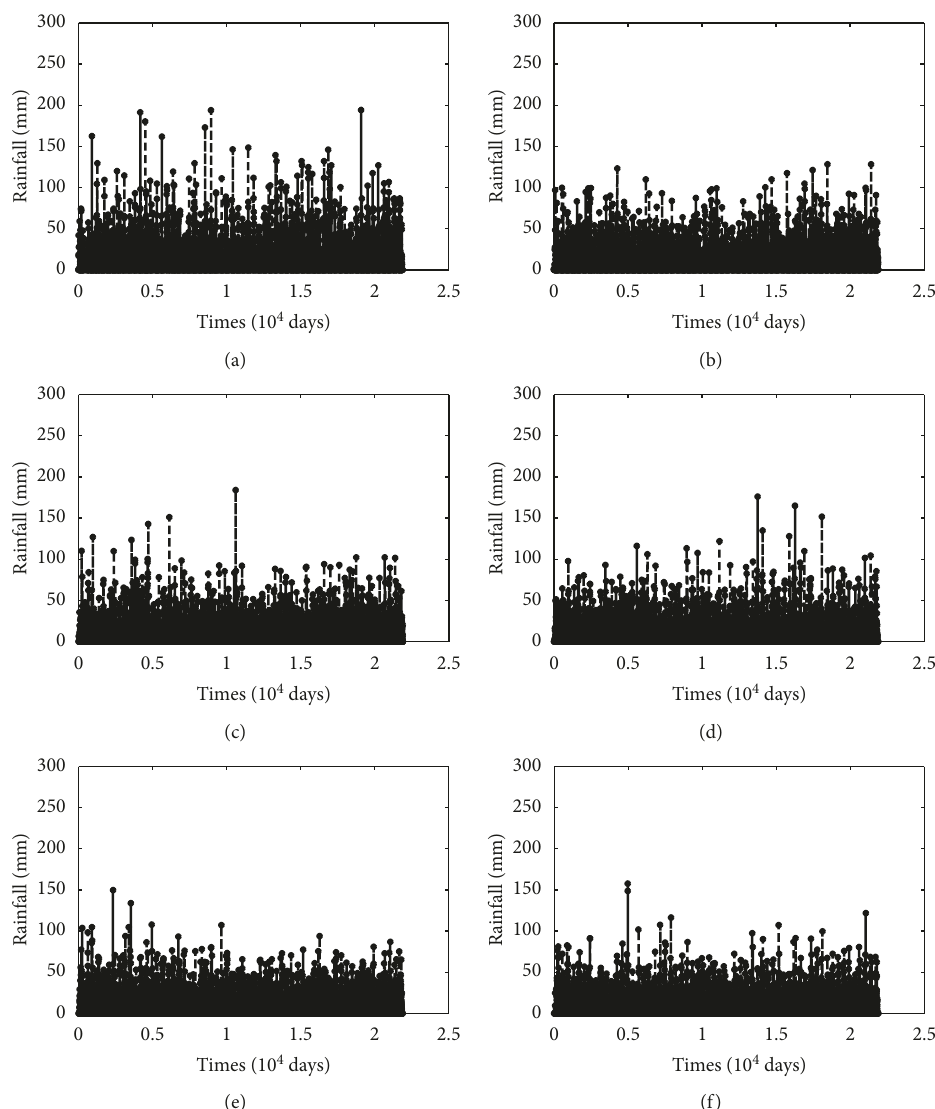
Figure 2: Temporal variations of rainfall time series collected from 1951 to 2010: (a) Cotonou station, (b) Bohicon station, (c) Sav`e station, (d) Parakou station, (e) Natitingou station, and (f) Kandi